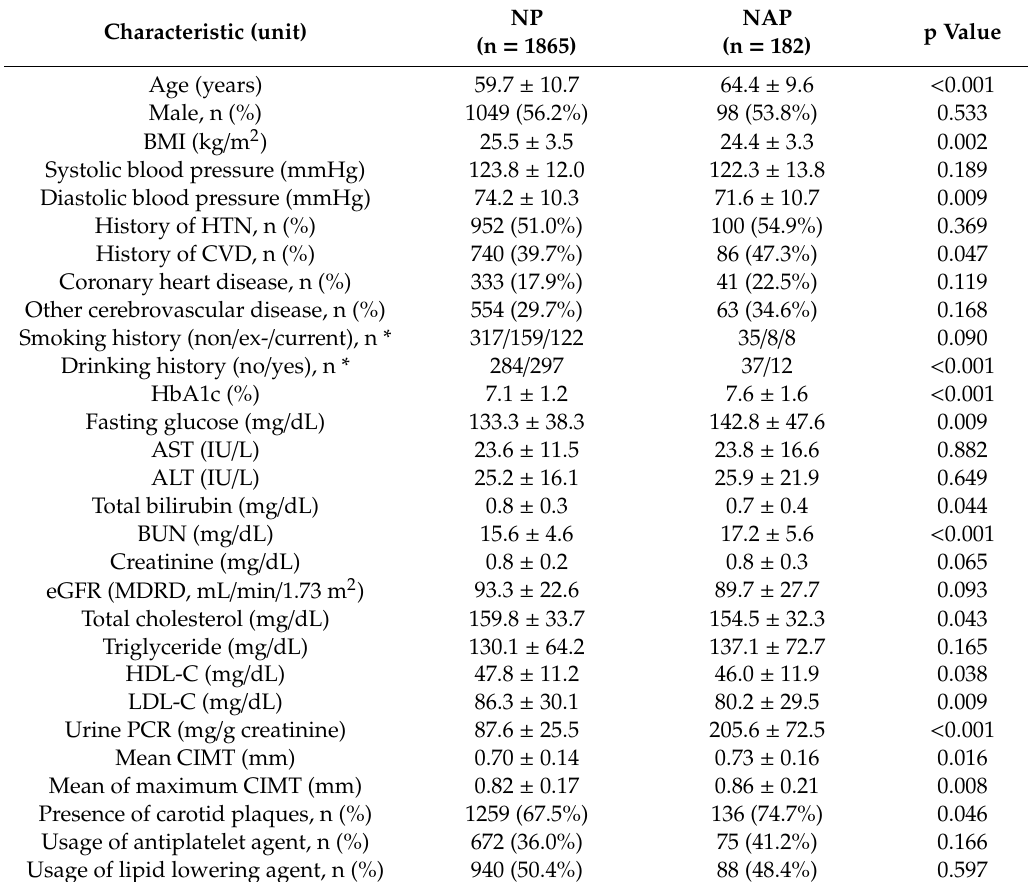
Table 1. Participants’ demographic and laboratory